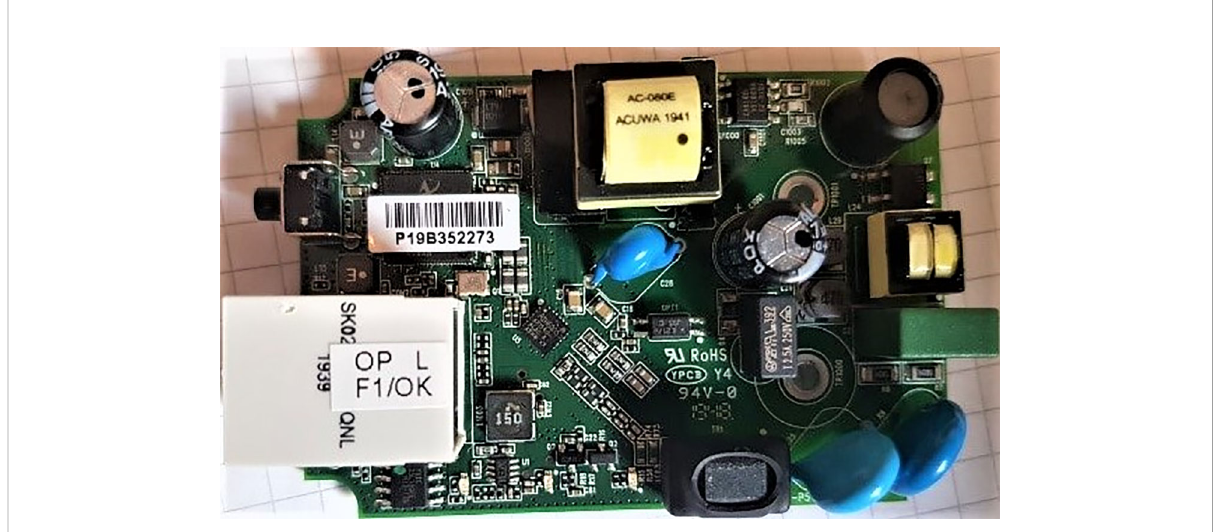
FIGURE 13 Front side of the power line adapter which was adapted and implicated into the